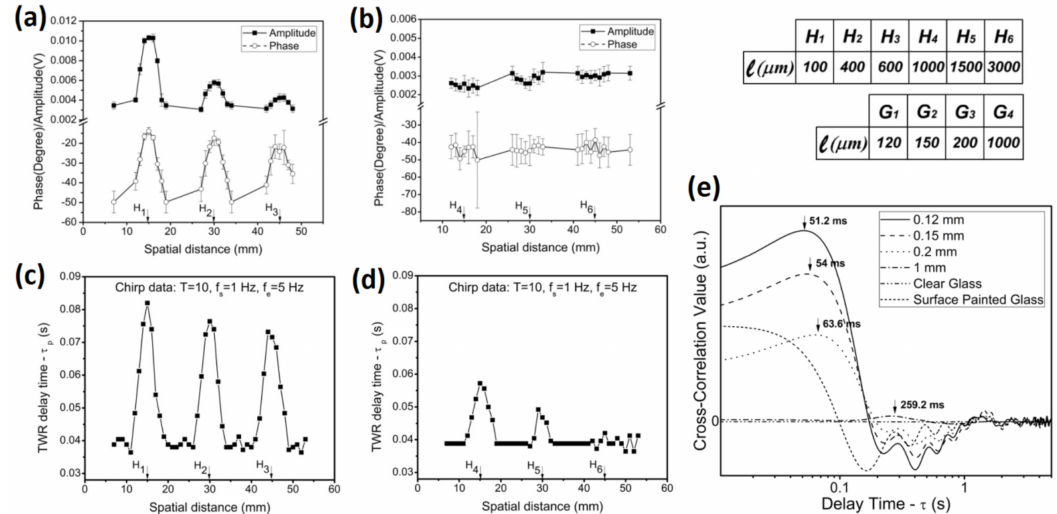
Figure 5. Experimental results obtained using ( a , b ) single-frequency photothermal radiometry and ( c , d ) TWR in an opaque sample with blind holes. Remaining thickness of holes are depicted in the insert; ( e ) experimental TWR responses from glass slides of various thicknesses painted on the black on the front or back surface